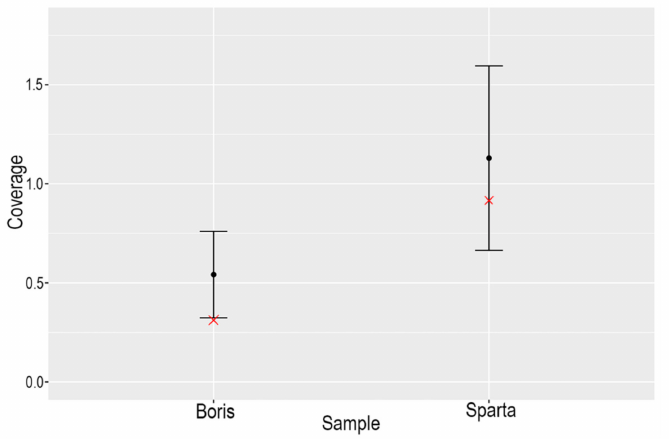
Figure 4. Plot of the coverage of the X chromosome (red ‘ × ’) for Boris and Sparta versus two standard deviations of the coverage of the autosomes for each